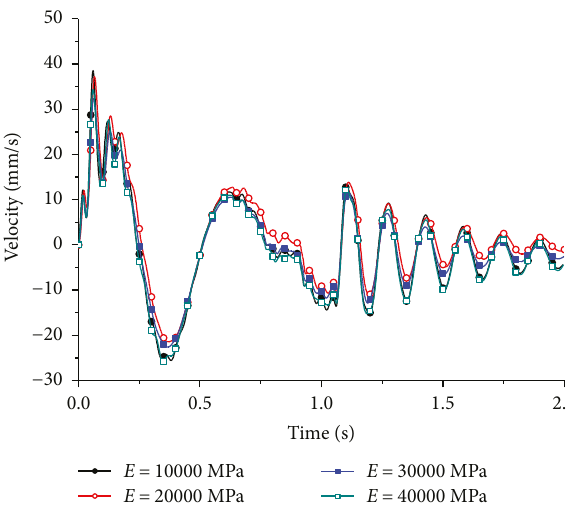
Figure 25: Vertical velocity of launch canister top at di ff erent elastic modulus.